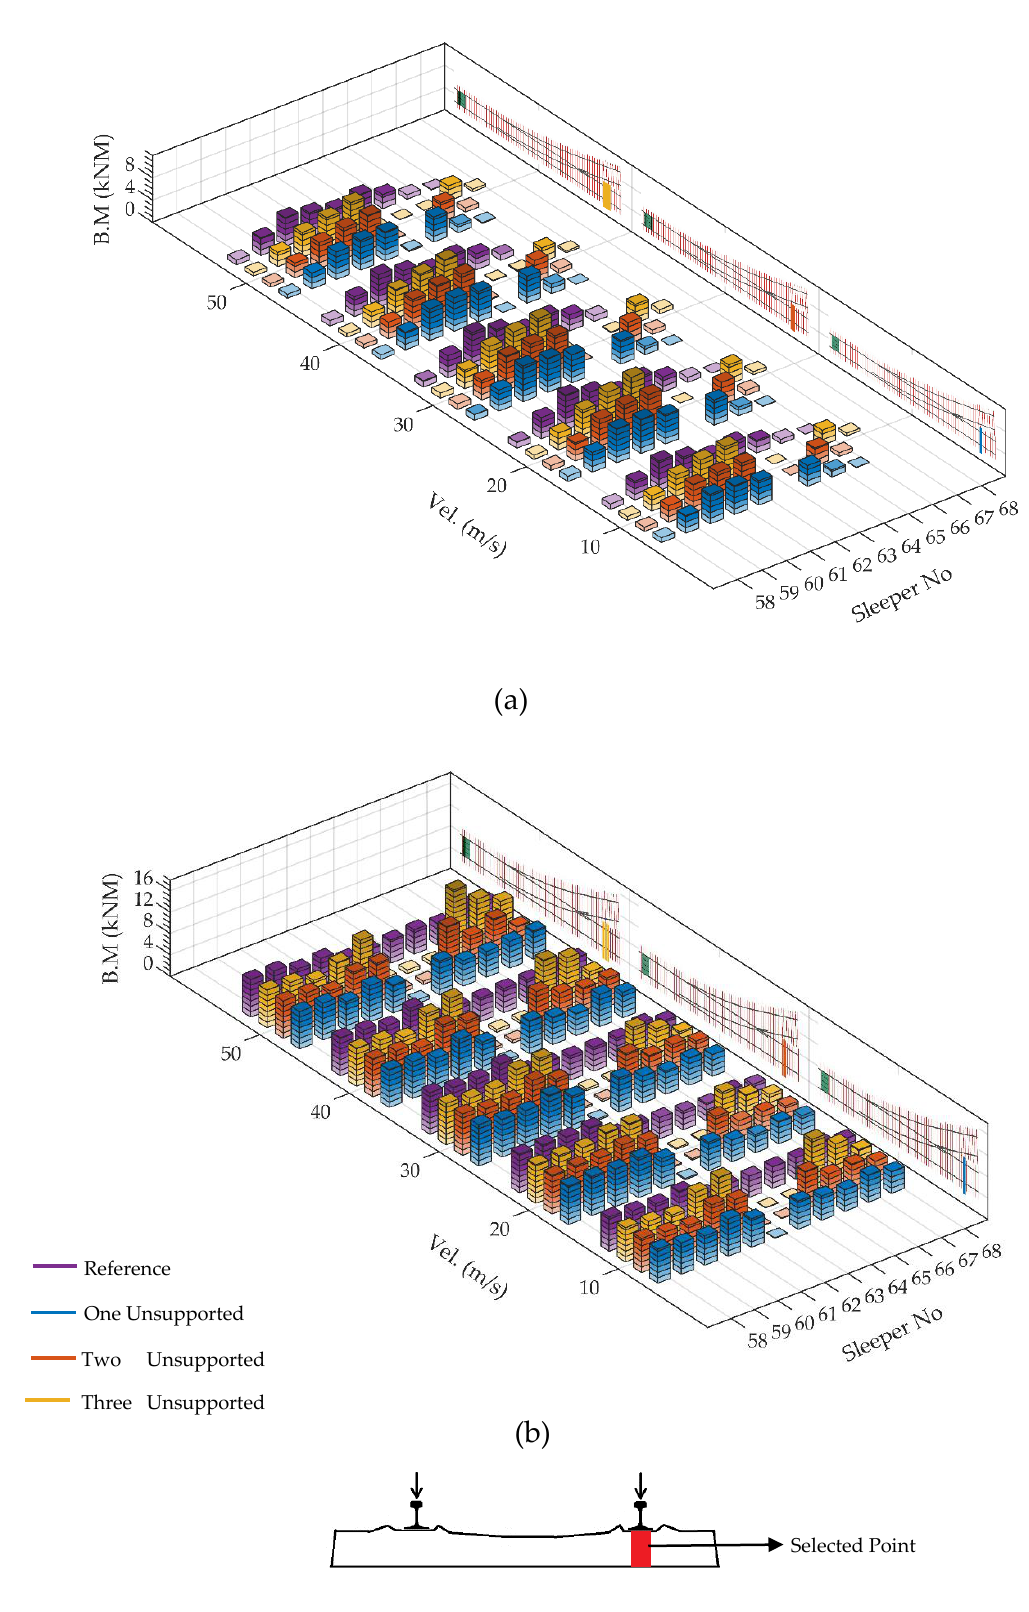
Figure 27. The distribution of positive bending moments over the bearers when the shortest bearer is unsupported: ( a ) at particular time when the front wheel is on the bearer with number 62; ( b ) when maximum occurs at each bearer.